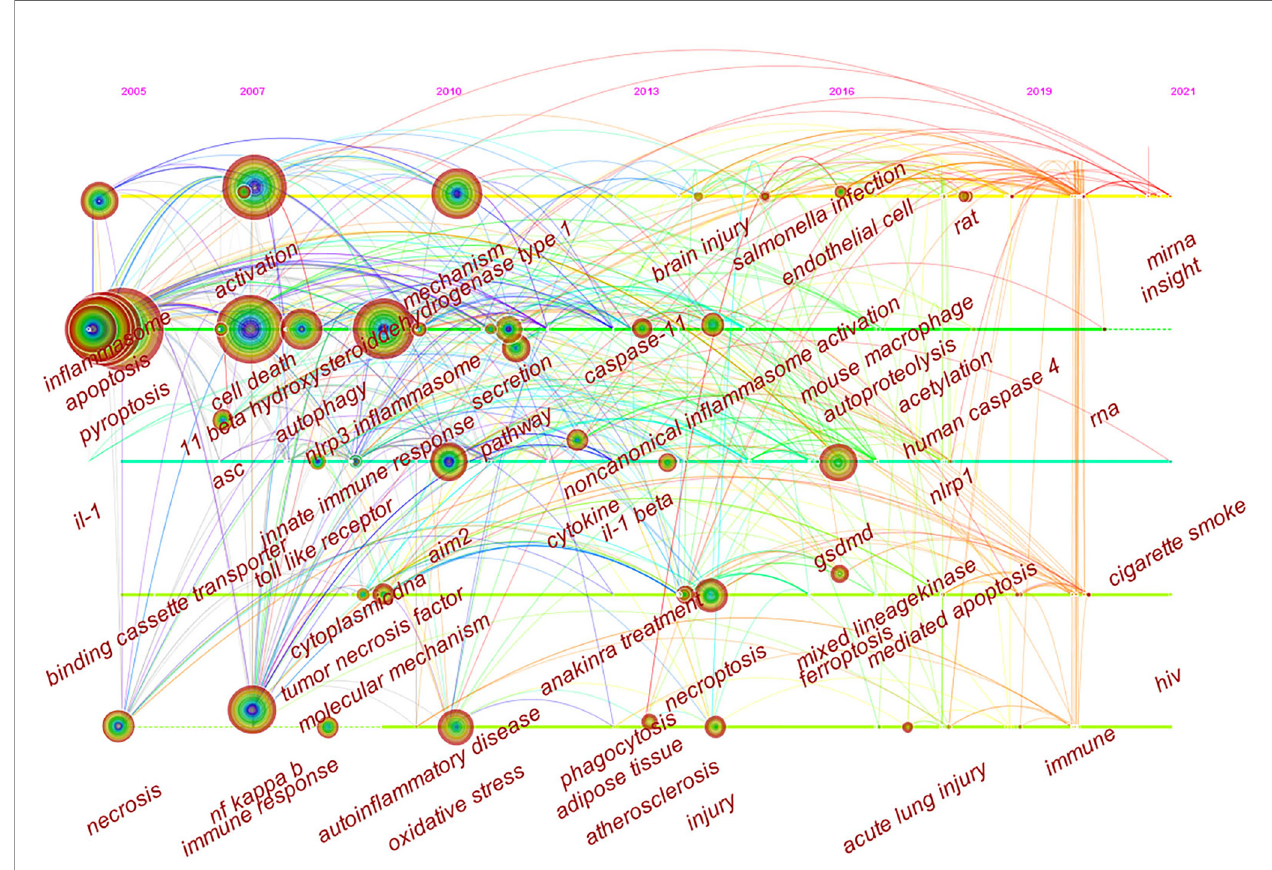
FIGURE 9 | CiteSpace visualization map of timeline viewer related to